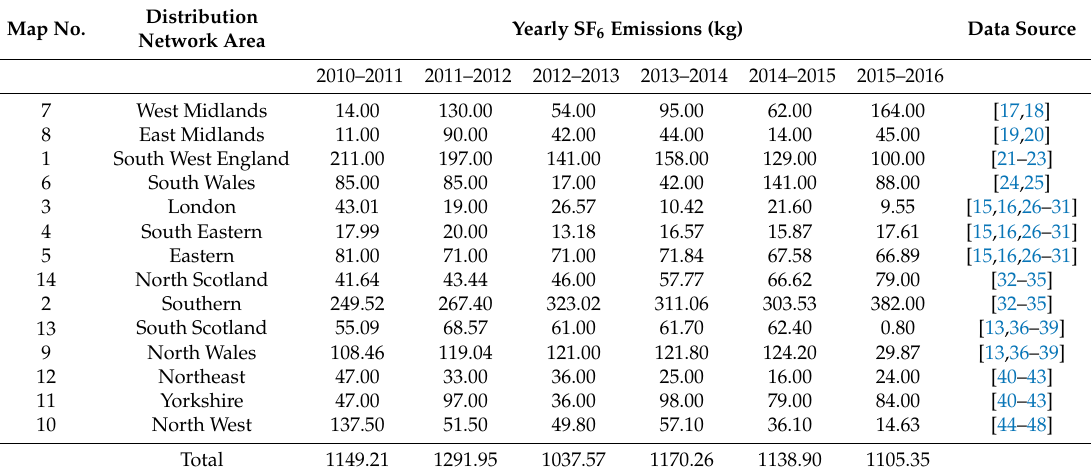
Table 1. SF 6 emissions (kg) by electricity distribution network area in Great Britain. Map No.